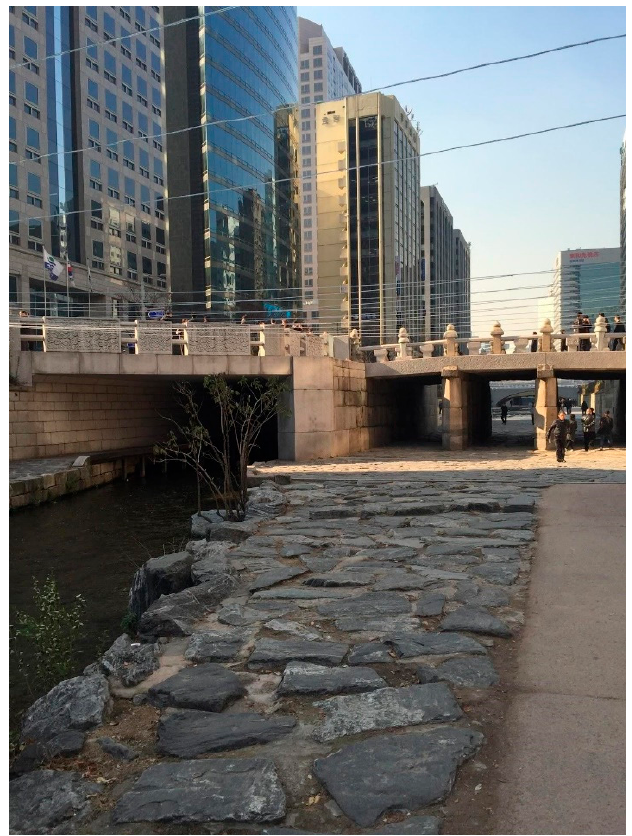
Figure 7. Restored Gwangtonggyo Bridge to the right.